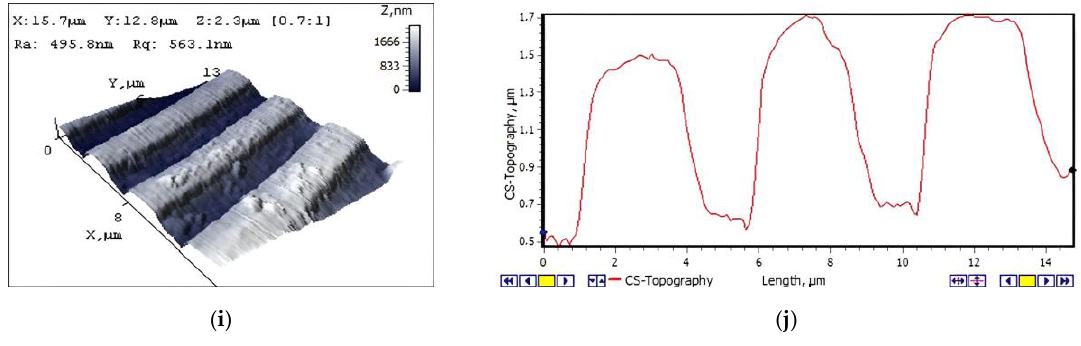
Figure 9. AFM topography images and surface profiles of embossed microstructures in thermoplastics with topography: ( a , b ) PETG; ( c , d ) PP; ( e , f ) PVC; ( g , h ) SAN; and ( i , j ) a nickel master grating.